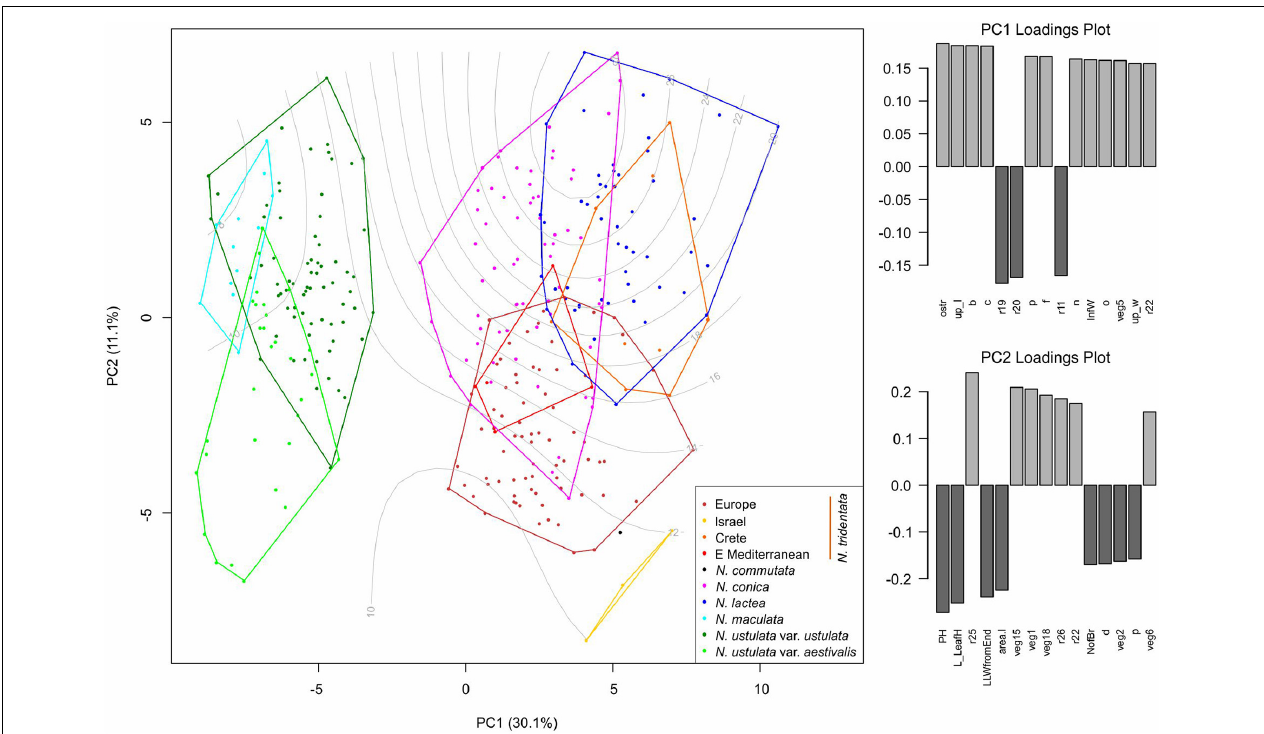
FIGURE 7 | Multivariate morphometrics: principal component analysis (PCA) of 323 individuals with the full record of data. The first and second axis are displayed with the indication of explained variation. Genome size variation (values in pg DNA) is passively projected on to the ordination space using the ordisurf function ( vegan R package) and shown as gray contour lines. The two right-hand panes show the ordered association of characters with the first and second PCA axis,